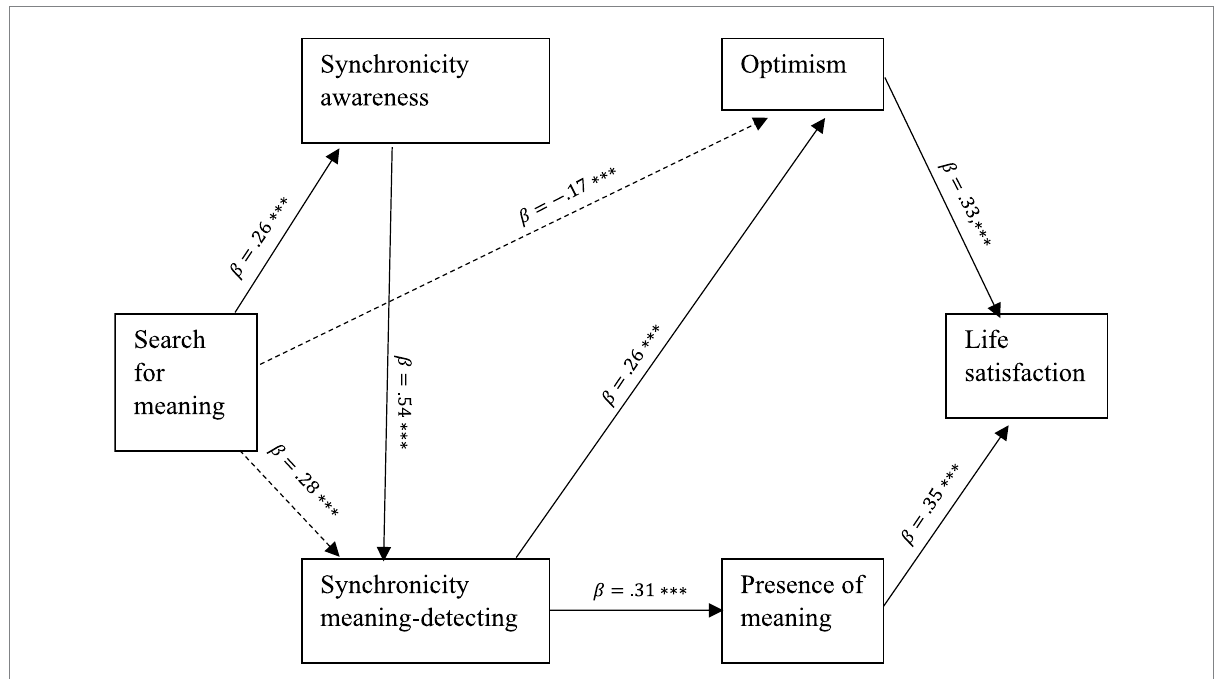
FIGURE 5 The model coefficients estimated via path analysis. Solid lines with arrows indicate paths in the original model. Dashed lines with arrows indicate paths added from modification indices. Numbers above lines indicate standardized path coefficients and significance values. *** p <